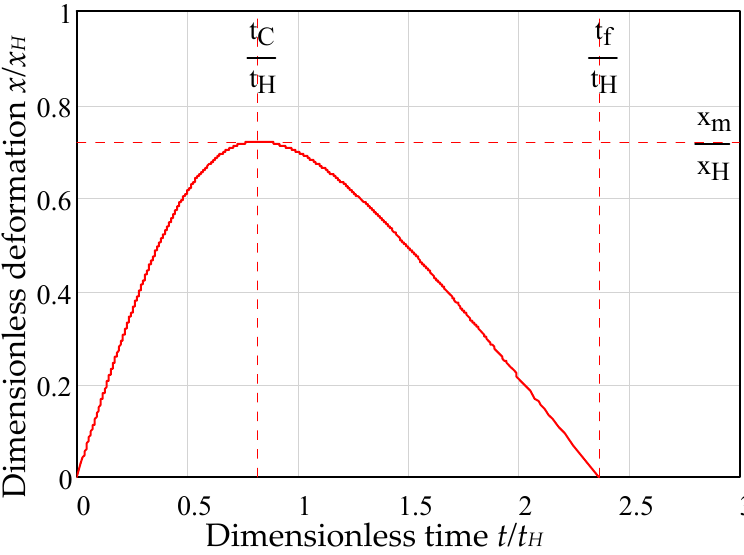
Figure 13. Approach variation with time.